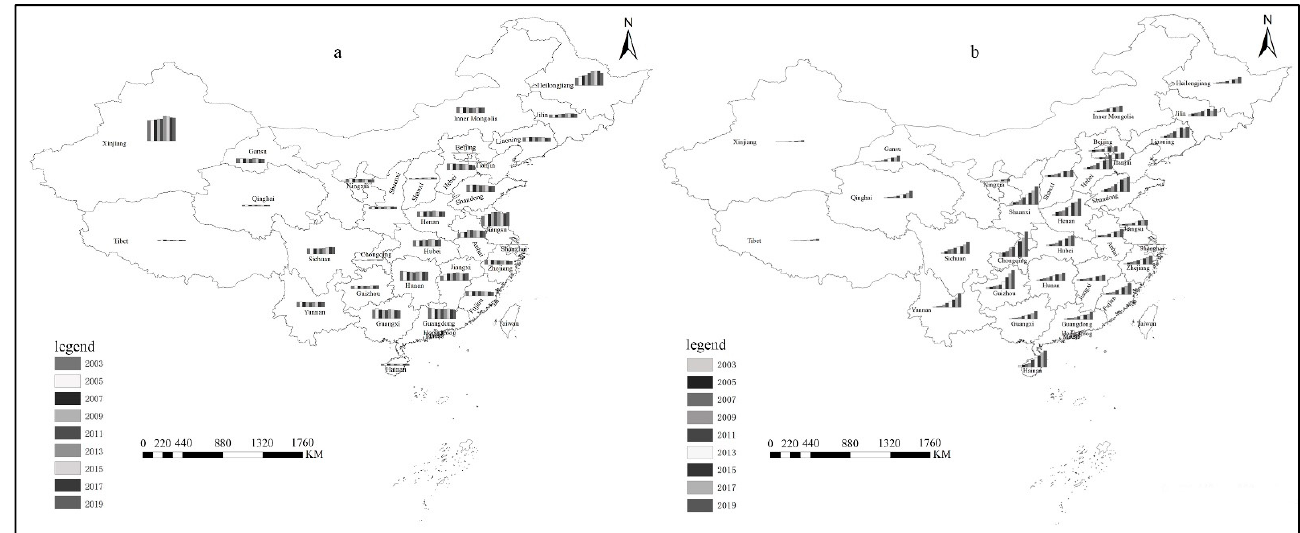
Figure 2. ( a ) Spatial distribution of agricultural water consumption; ( b ) spatial distribution of the output intensity of agricultural water.